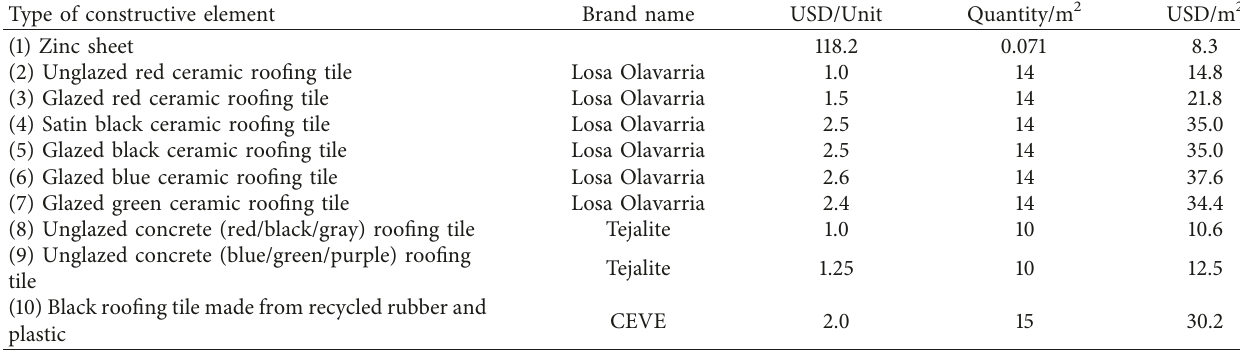
Table 5: Prices of constructive elements for house cover. Type of constructive